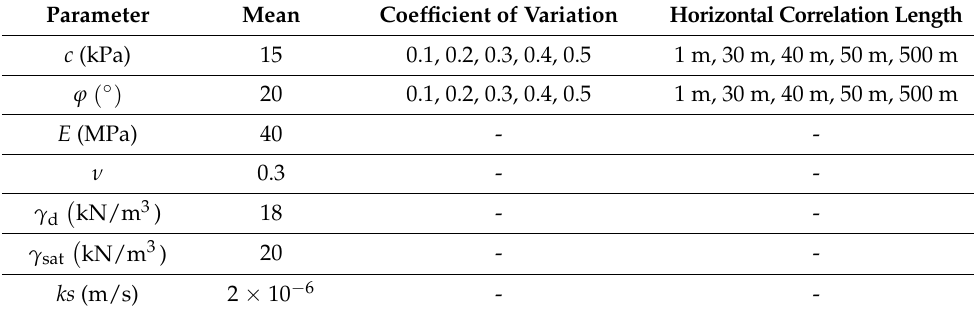
Table 1. Statistical properties of soil